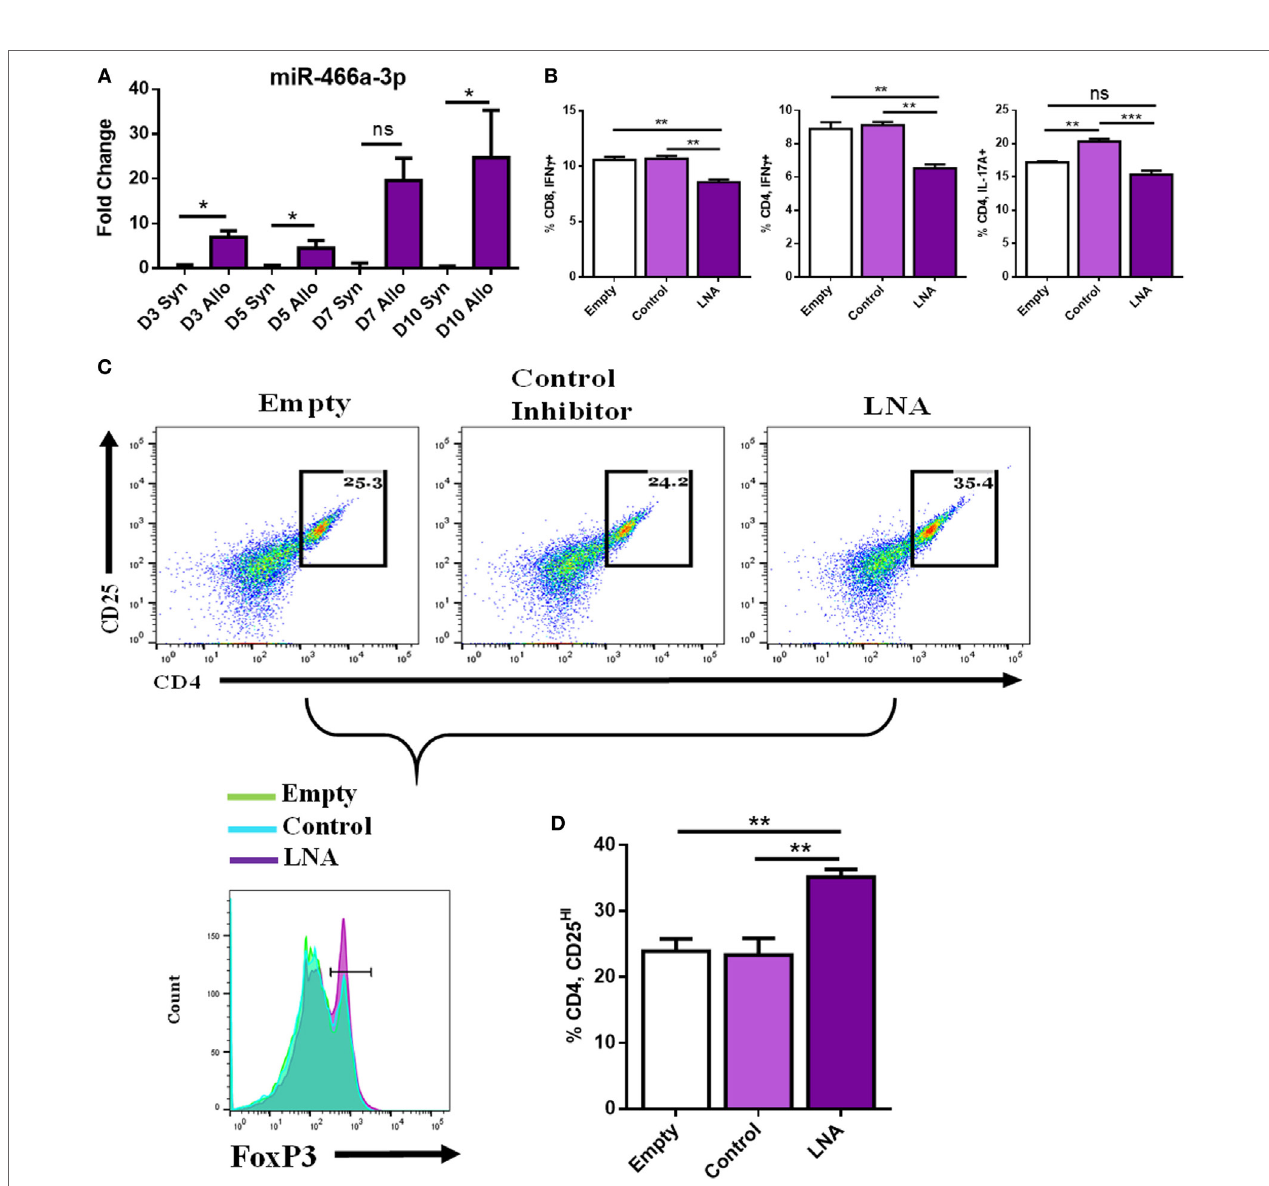
FigUre 3 | MicroRNA (miRNA) 466a-3p transfection inhibits regulatory T cell (Treg) polarization. Purified naïve CD4 + T cells were cultured under Treg-polarizing conditions along with the indicated mimic, control, or inhibitor conditions. Cells were harvested 48 h after addition of cytokines and miRNA mimics, inhibitors, or controls and subject to flow cytometry, immunoblot and quantitative real-time-PCR. The success of Treg polarization is examined as (a) representative dot plots gated on CD25HI cells and quantified in (B,c) . Representative immunoblots of indicated proteins are presented in (D,F) , along with associated densitometric measurements of transforming growth factor-beta 2 (TGF- β 2) and TGF- β R3 (e) , and quantification of activated Smad 2, 3, and 4 (g) . CD4 + cells were purified from naïve mouse lymph nodes and stimulated ex vivo with CD3 (3 µg/mL) and CD28 (3 µg/mL) for 48 h and administered Locked Nucleic Acid or controls at the time of seeding. Quantification of flow cytometry data from LAP-expressing FoxP3 positive Treg cells. (h) Purified naïve CD4 + T cells were cultured with either TGF- β 1 (5 ng/ mL) or TGF- β 2 (5 ng/mL), along with CD3 (3 µg/mL), CD28 (3 µg/mL), and IL-2 (5 ng/mL) for 5 days. (i) representative dot plots of FoxP3, CD4-positive Tregs gated on CD25HI, (J) , and their associated CD278 (ICOS) expression. Data are presented as mean ± SEM of three independent transfection experiments. * P < 0.05, ** P < 0.005, **** P < 0.0001 by ANOVA with Tukey’s multiple comparison